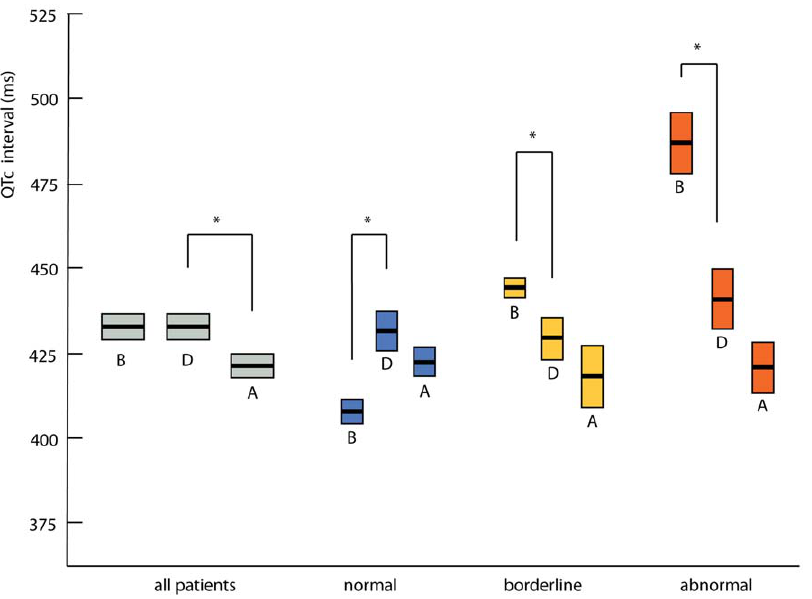
Figure 2. Course of changes in QTc duration before, during and after haloperidol use. Mean QTc intervals before, during and after haloperidol use of total patient group and of each subgroup, with Standard Errors of the mean. Normal: male # 430 ms, female # 450 ms, borderline: male 431–450 ms, female 451–470 ms, abnormal: male . 450 ms, female . 470 ms. B: before haloperidol use, D: during haloperidol use, A: after haloperidol use. * indicates significant change at p , 0.05